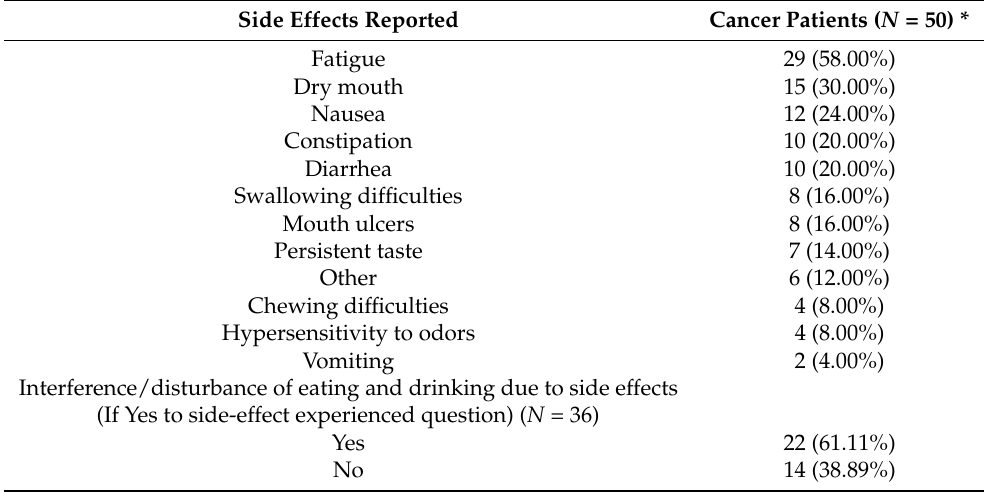
Table 2. Side effects, important food attributes, and snack preferences reported by cancer patients undergoing treatment.